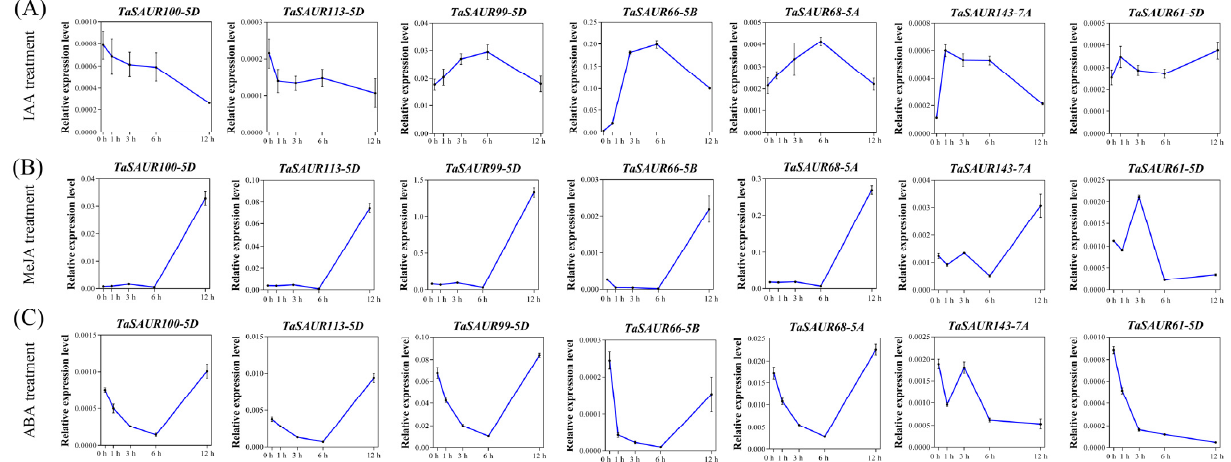
Figure 4. The expression patterns of TaSAUR genes under different hormone treatments. Real-time PCR analysis of the expression levels of 7 TaSAUR genes were performed in the roots of 2-week-old wheat seedlings under 30 mg·L − 1 IAA ( A ), 100 μ mol·L − 1 methyl jasmonate (MeJA) ( B ), or 100 μ mol·L − 1 abscisic acid (ABA) ( C ) treatments, respectively. The 2 − △ Ct method was employed to calculate the relative gene expression level, with β -TaTubulin as the reference gene. Data are presented as means ± SD of three independent biological replicates.